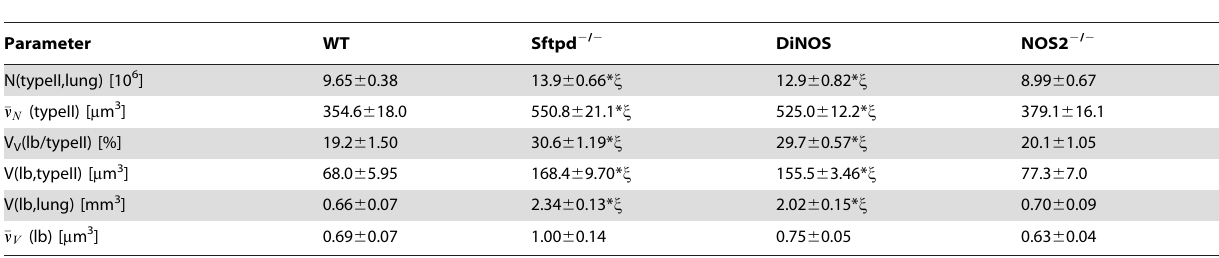
Table 2. Stereological data: AE2 cells and intracellular